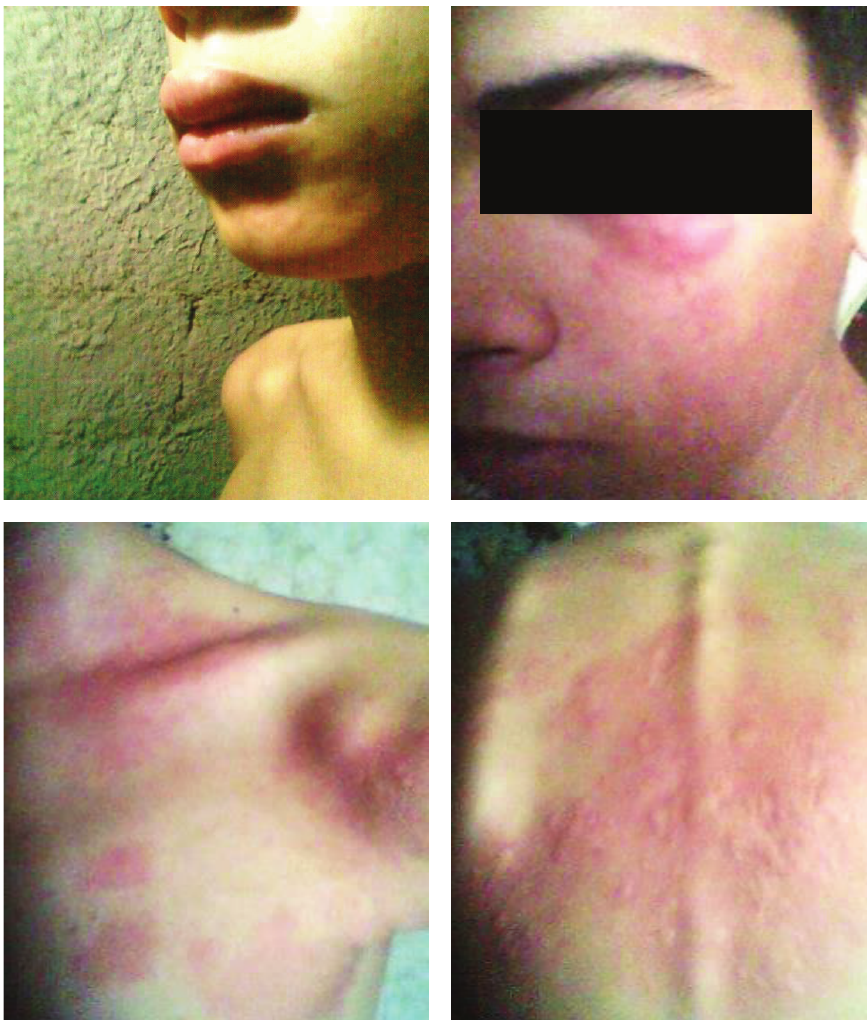
Figure 3: Allergic reaction to Detemir. Note distribution of wheals and flares, as well as angioedema of lips and eyelids.